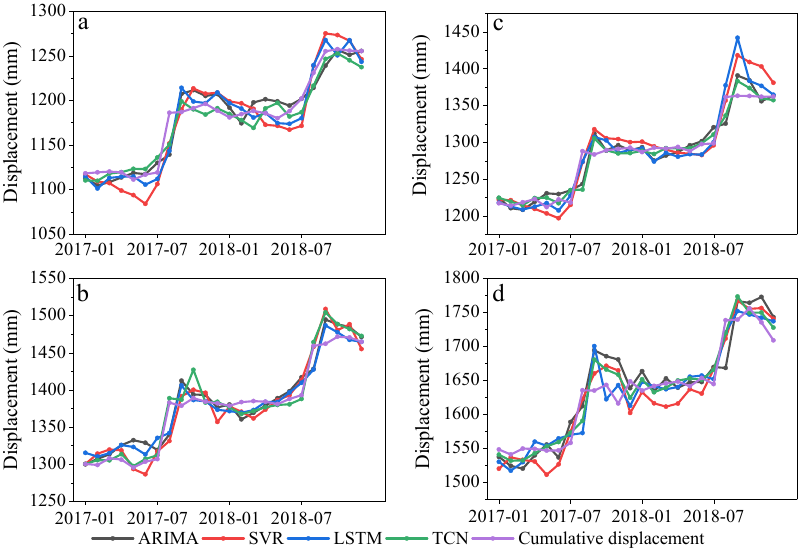
Figure 11. ( a ) Comparison of different models for cumulative displacement in ZG323; ( b ) comparison of different models for cumulative displacement in ZG324; ( c ) comparison of different models for cumulative displacement in ZG325; ( d ) comparison of different models for cumulative displacement in ZG326. Table 6. Prediction accuracy of cumulative displacement in ZG323 to ZG326.